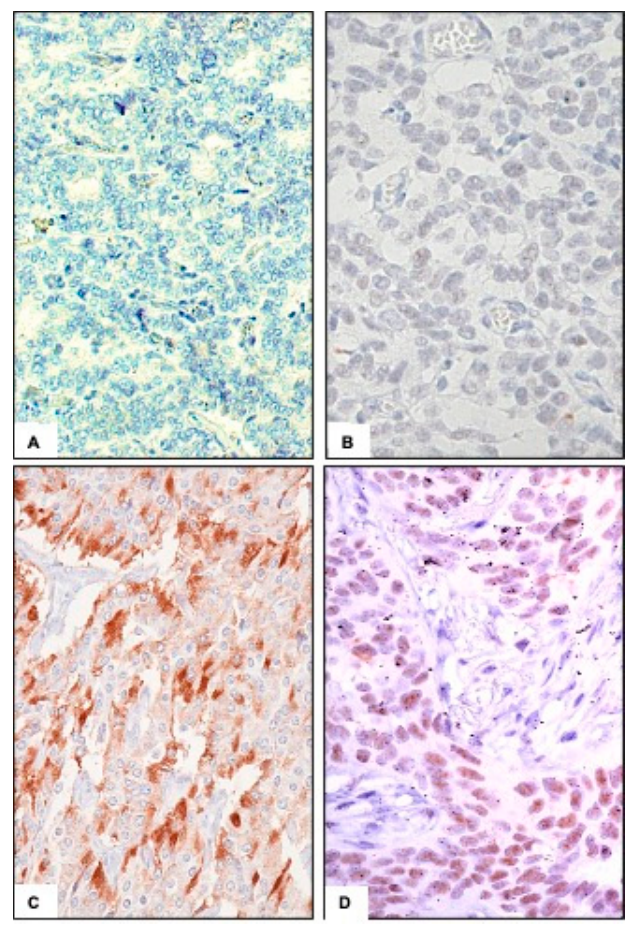
Figure 1. Immunohistochemical diffuse staining of p-mammalian target of Rapamicin (p-mTOR) ( C ) and p-S6K ( D ) in a case of neuroendocrine tumors (NET) of the ileum (200-fold magnification). Negative controls are shown in A and B .